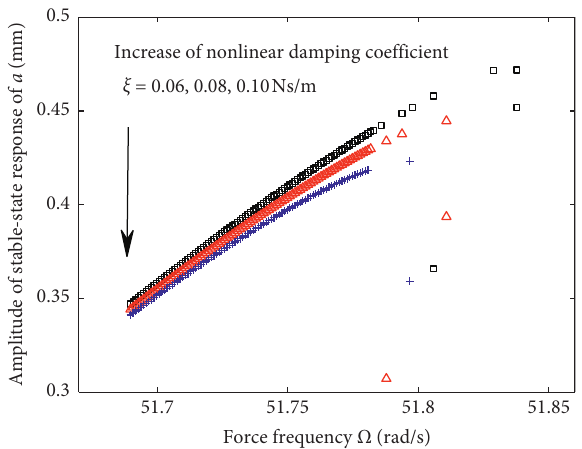
Figure 3: Effect of nonlinear damping on the stable vibration solution.